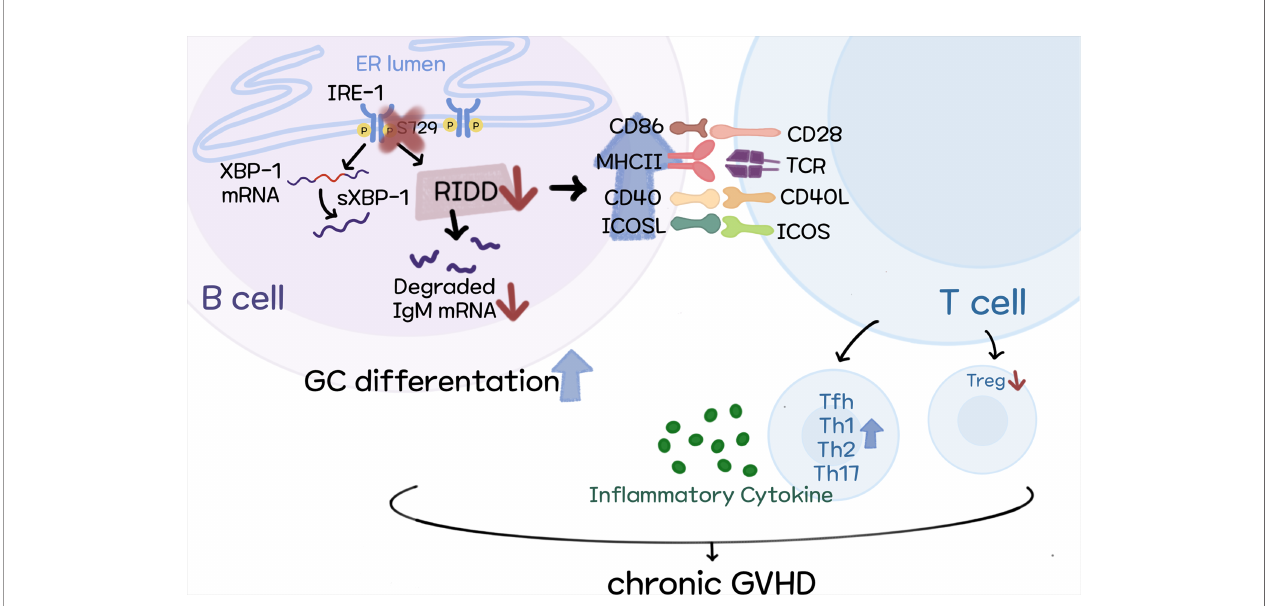
FIGURE 8 | Schematic diagram of our proposed